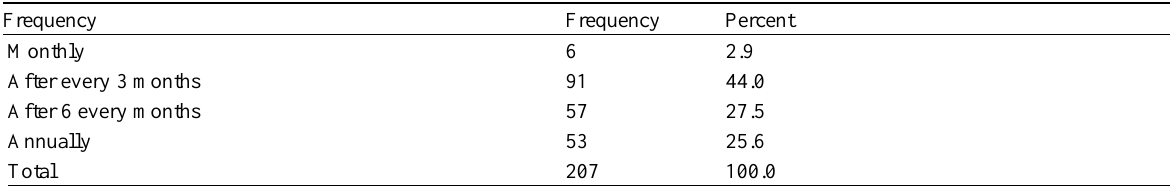
Table 11: Frequency of Training